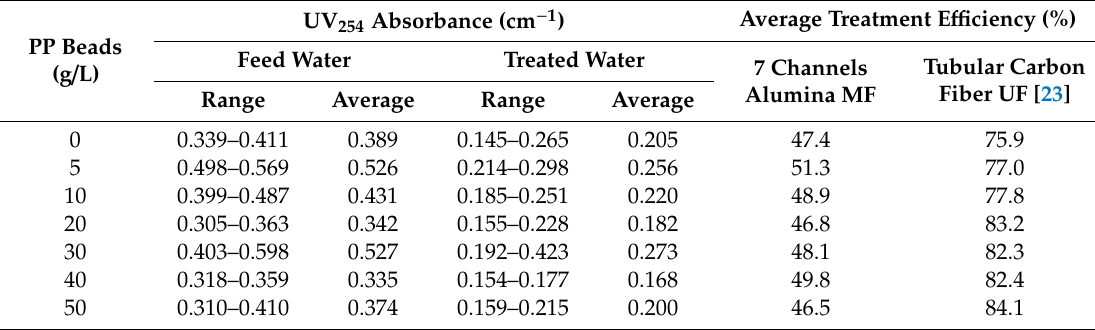
Table 7. Water quality and treatment e ffi ciency of DOM (UV 254 absorbance) in the hybrid process of 7-channel alumina MF (HC10) and PP beads for the e ff ect of PP beads concentration as compared with results of tubular carbon fiber UF (C005) membrane.